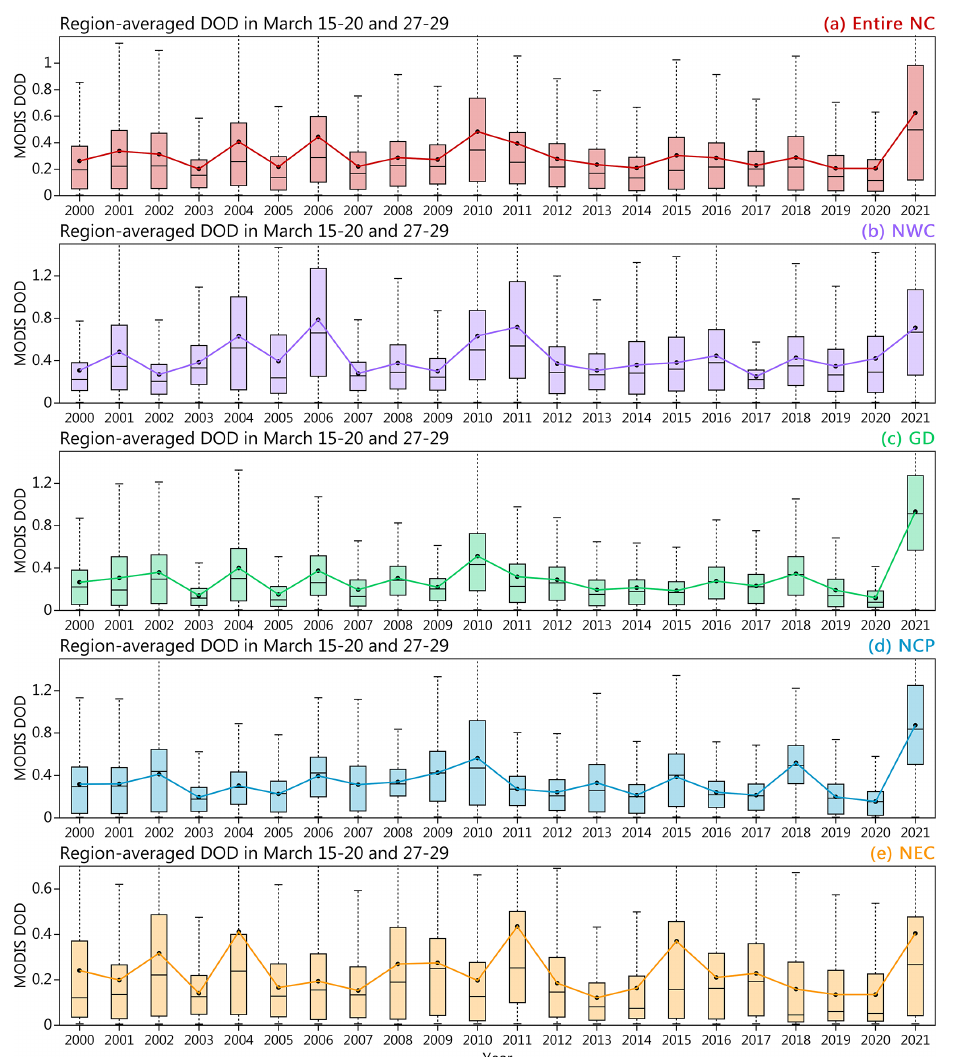
Figure 17. As in Fig. 15 but for the combined MODIS-retrieved DOD from Terra and Aqua during the combined period of 15–20 and 27–29